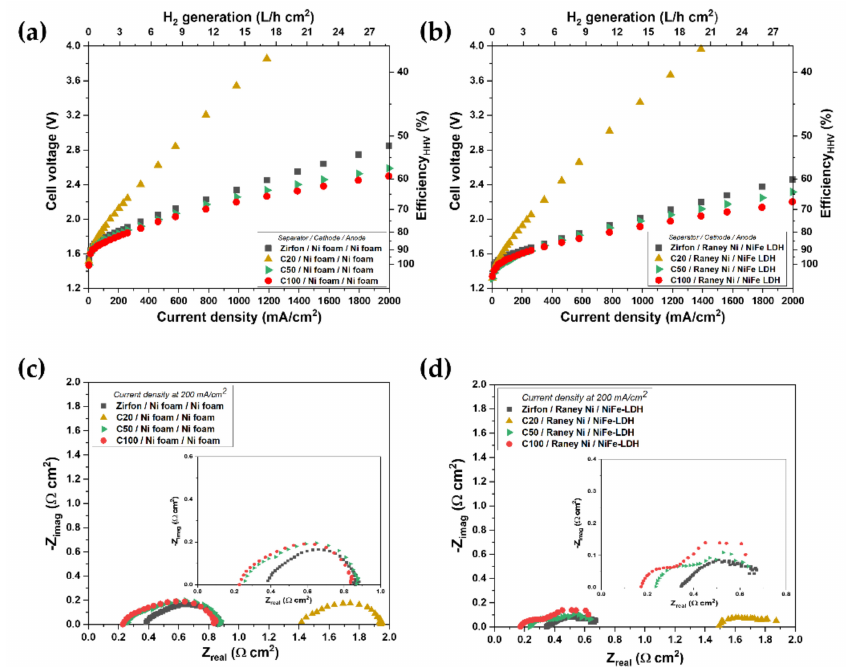
Figure 5. In-situ polarization curve and impedance spectra of a single cell with ( a , c ) Ni foam / cathode—Ni foam / anode and ( b , d ) Raney Ni / cathode—NiFe Layard double hydroxide (LDH) / anode in 30 wt% potassium hydroxide (KOH) solution at 80 ◦ C (the inset showed the closed-up at low impedance